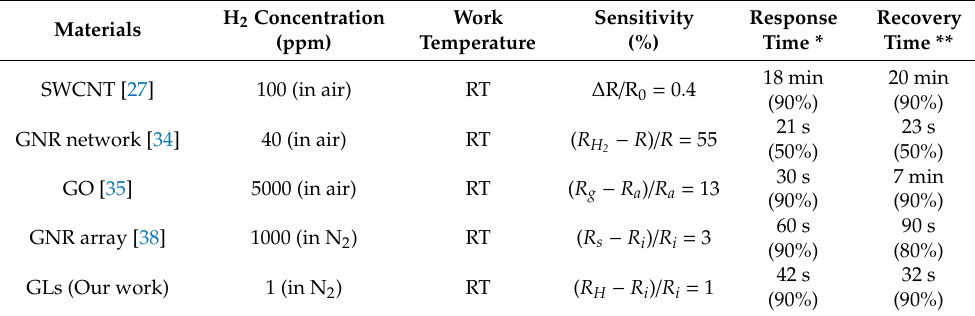
Table 1. Carbon materials-based sensors for H 2